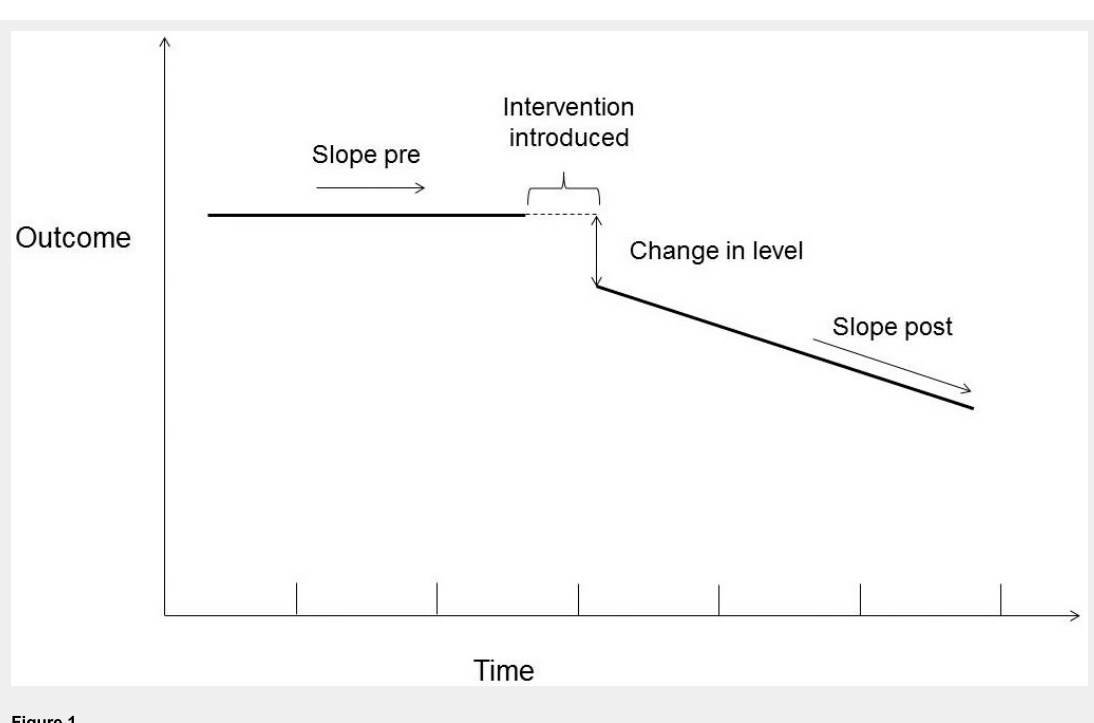
Key elements of interrupted time series design. Adapted according to Matowe